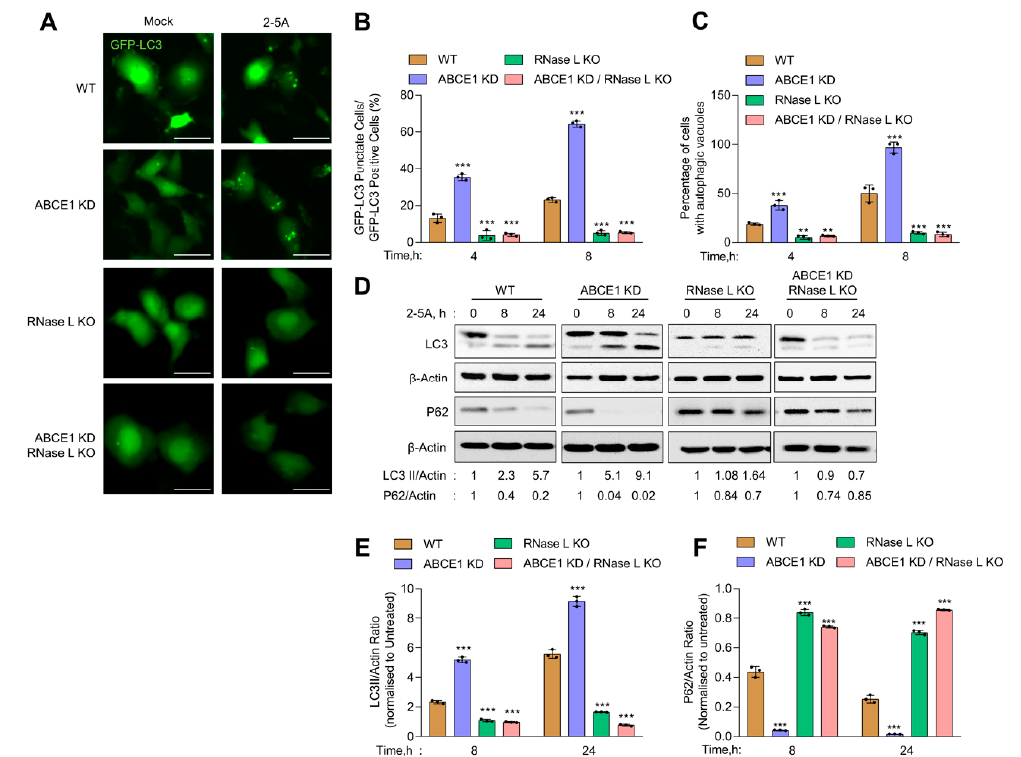
Figure 2. Early onset of autophagy in ABCE1 KD cells on RNase L activation. HT1080 WT, ABCE1 KD, RNase L KO, and ABCE1 KD/RNase L KO cells expressing GFP-LC3 were mock-transfected or transfected with 2-5A (10 μ M) and ( A ) the formation of GFP-LC3 puncta was microscopically imaged after 8 h; scale bar 50 μ m. ( B ) The percent of GFP+ cells showing puncta formation compared with mock-treated cells was analyzed. ( C ) Autophagy induction in live cells was evaluated by staining autophagic vacuoles and quantified. Results shown represent mean ± SD for the experiment performed in triplicate and shown as the percent cells showing autophagic vacuoles from randomly selected fields. ( D ) Cell lysates were harvested at indicated times, and the conversion of unconjugated LC3-I to lipidated LC3-II and degradation of p62 were monitored on immunoblots and normalized to β -actin levels. ( E , F ) The band intensity was calculated using Image J software, and the ratio of LC3-II/ β -actin or p62/ β -actin was determined and the levels were compared to WT cells. Results are representative of three independent experiments. WT: wild-type; ** p < 0.01; *** p < 0.001.